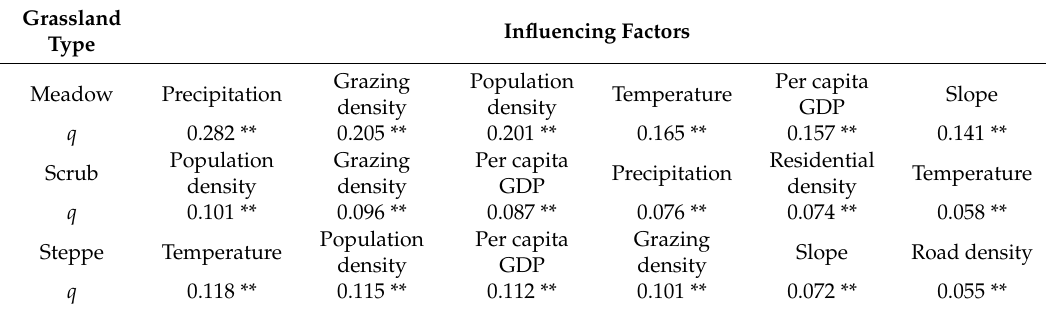
Figure 6. q values for seven physical factors and six anthropogenic factors guiding the distribution of NDVI variation. It denotes the determination power of driving factors on vegetation variation. Seven physical factors, As, ST, SD, SI, E, T and P represent aspect, soil type, sunshine duration, slope, elevation, temperature, and precipitation, respectively. Six anthropogenic factors, GDP, PD, GI, ReD, LU and RoD represent per capita GDP, population density, grazing density, residential density, land use, and road density, respectively. Table 2. Main influencing factors and corresponding q values in different vegetation types. Factor and ecological detector models were used to determine the most powerful factors affecting the spatial distribution of NDVI variation.